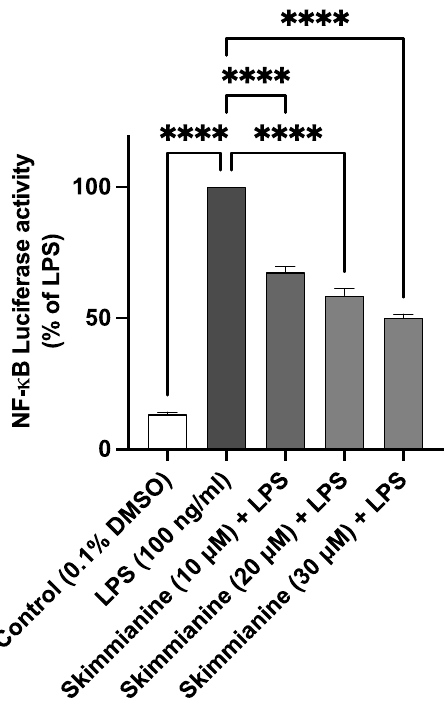
Figure 6. Skimmianine inhibits LPS-induced NF- κ B-mediated gene expression. BV-2 microglia transiently transfected with a firefly luciferase gene driven by an NF- κ B-regulated promoter were pre-treated for 30 min with skimmianine before stimulation with LPS (100 ng/mL) for 6 h. The cells were then lysed, and extracts were analysed for luciferase activity. A statistical analysis was carried out using a one-way ANOVA with a post hoc Dunnett’s test. Values are mean ± SEM of at least three independent experiments. **** p < 0.0001 in comparison with LPS stimulation.